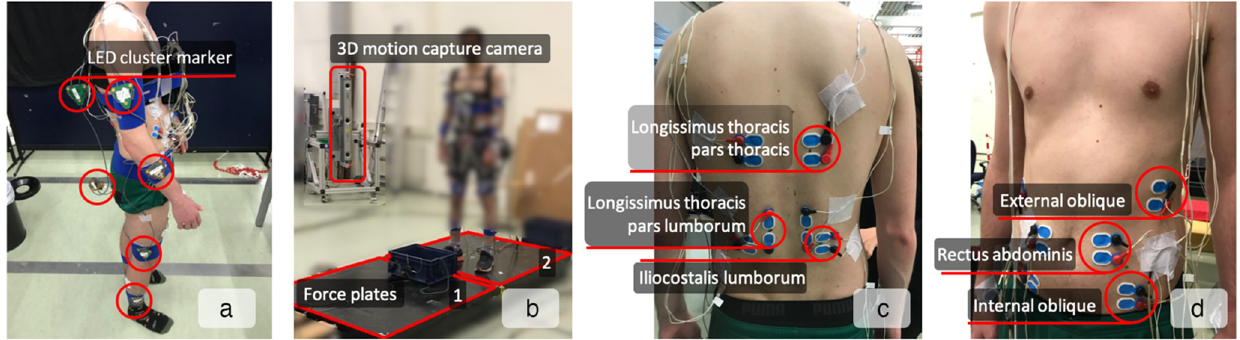
Figure 1. Experimental setup. ( a ) Ten LED cluster markers were attached to lower legs, upper legs, lower arms, upper arms, pelvis, and trunk (T10 level). The cluster markers on the pelvis and trunk were attached using rigid structures for better visibility. The cluster markers attached to the left lower leg, left upper leg, left lower arm, and left upper arm are not visible due to the camera’s position. ( b ) Three-dimensional motion capture cameras around the experimental setup collected marker positions and force plates measured ground reaction forces and moments. One out of four cameras is